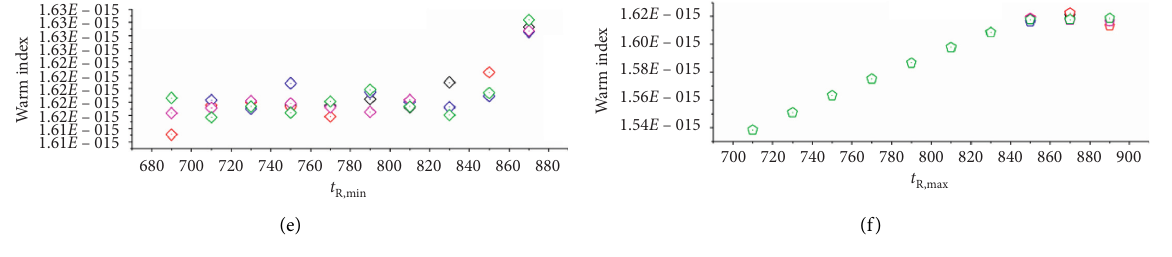
Figure 15: Warming index of each